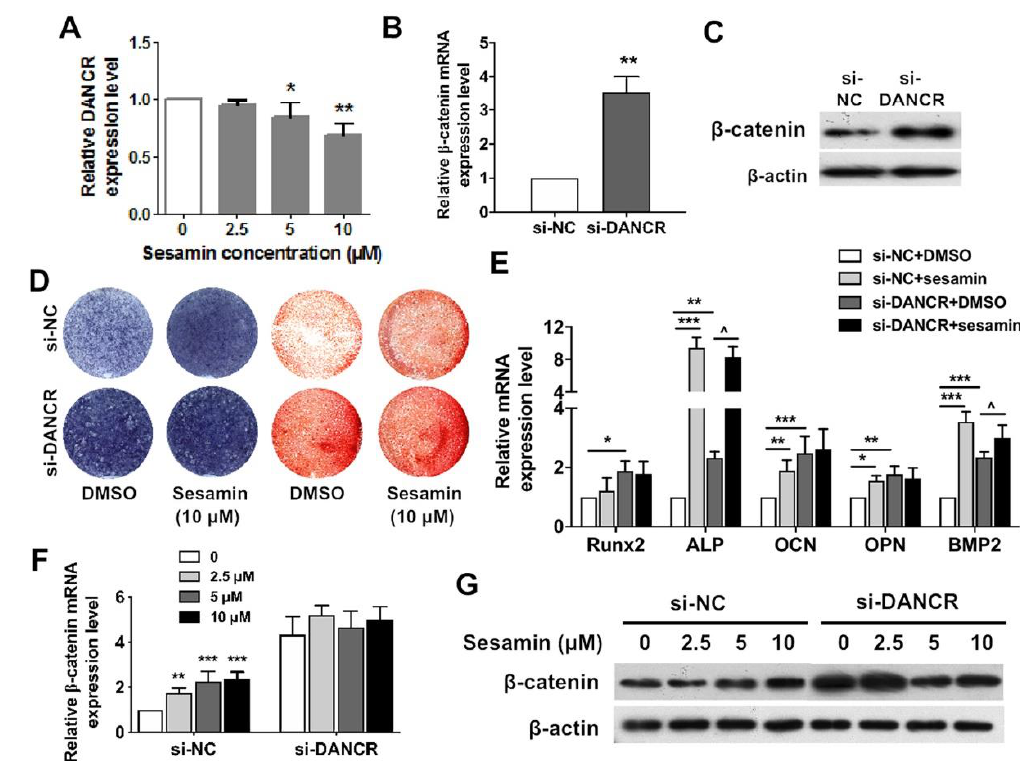
Figure 4. Knockdown of DANCR attenuated the Osteogenic effect of sesamin. ( A ) . DANCR expression level decreased in BMSCs upon sesamin treatment ( n = 6; * p < 0.05, ** p < 0.01). ( B , C ). DANCR knockdown upregulated the mRNA ( B ) and protein ( C ) expression level of β -catenin ( n = 6; ** p < 0.01). ( D , E ). The BMSCs were DANCR knockdown and treated with sesamin during osteo-induction for 7 days. ALP activity, calcified nodules formation ( D ) and mRNA expression level of osteogenic marker genes ( E ) were examined by ALP activity assay, ARS staining and real-time PCR, respectively ( n = 6; * p < 0.05, ** p < 0.01, *** p < 0.001, versus si-NC+DMSO group; ^ p < 0.05, versus si-DANCR+DMSO group). ( F , G ) . Sesamin up- regulated the expression of β -catenin in mouse BMSCs at both mRNA ( F ) and protein ( G ) expression levels, this up-regulation was attenuated upon si-DANCR treatment ( n = 6; ** p < 0.01, *** p < 0.001).